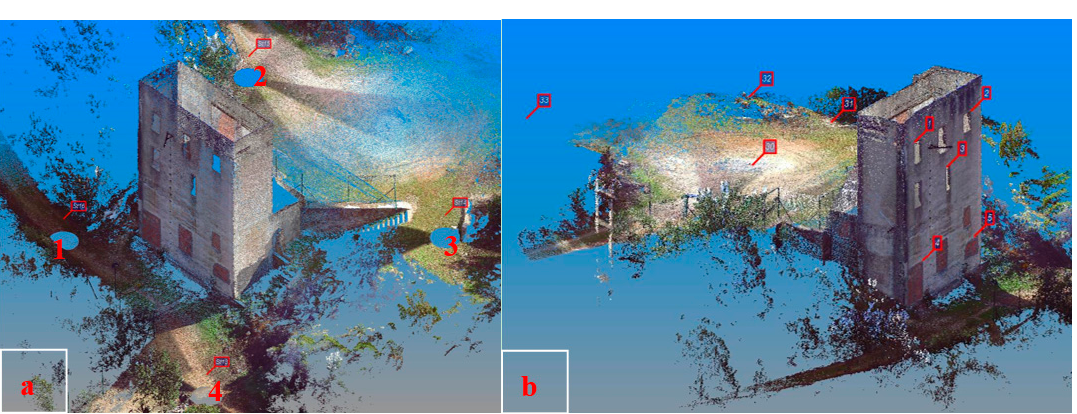
Figure 17. Oblique flight.